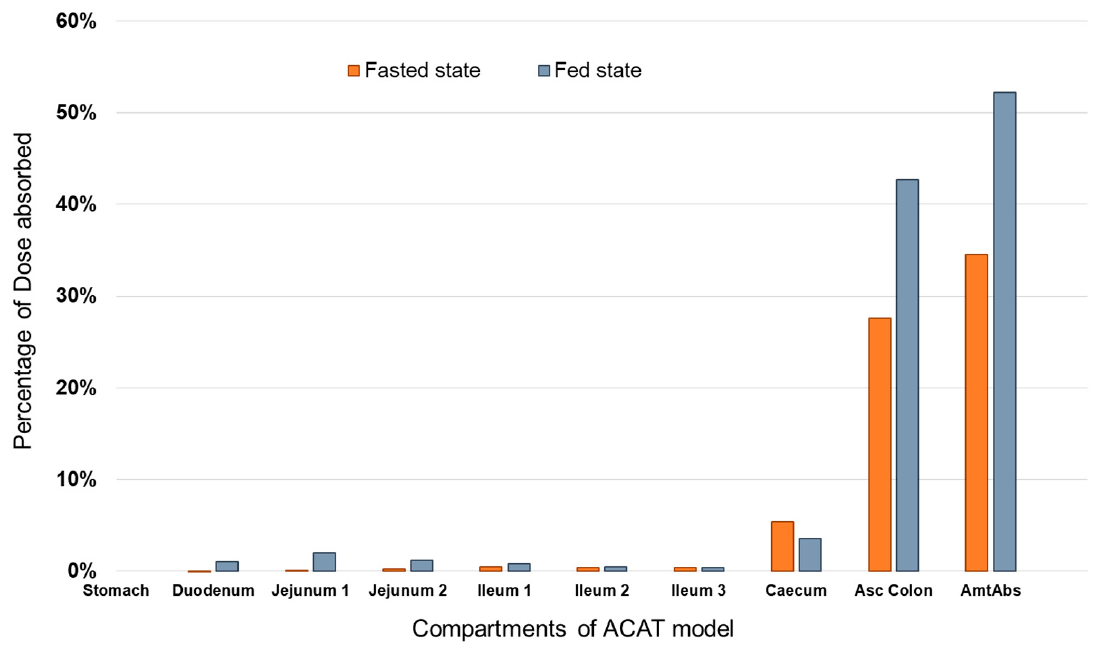
Figure 5. Bar chart representing the predicted regional absorption of PAL released from 6 mg PAL ER OROS tablet under fasted (orange bars) and fed (light-grey bars) conditions. AmtAbs represents the total amount absorbed of the drug for all GI compartments when taken together .